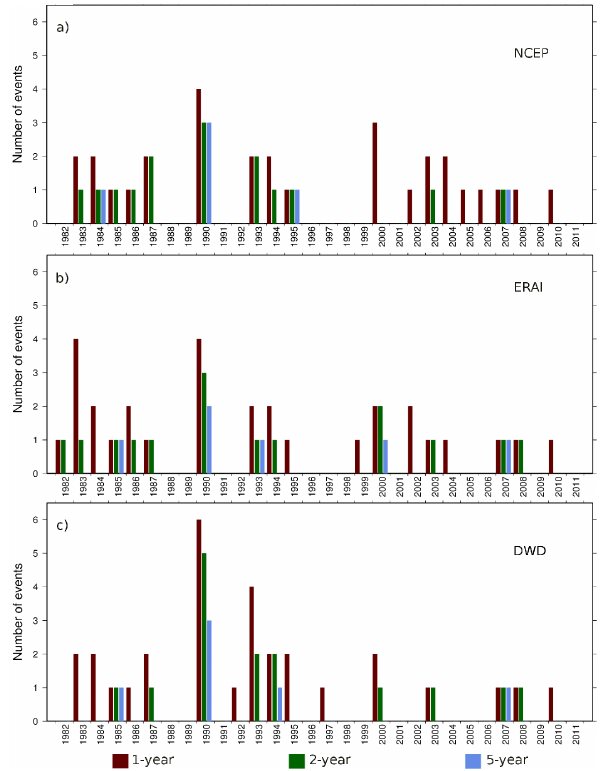
Figure 3. Time series of the number of events per winter exceeding the 1-year return level (red), 2-year return level (green) and 5-year return level (blue) between 1981/82 and 2010/11. (a) LI estimated based on NCEP; (b) same as (a) but for ERAI; (c) same as (a) but for DWD gust. The indicated year corresponds to the second year of a winter (2000 indicates